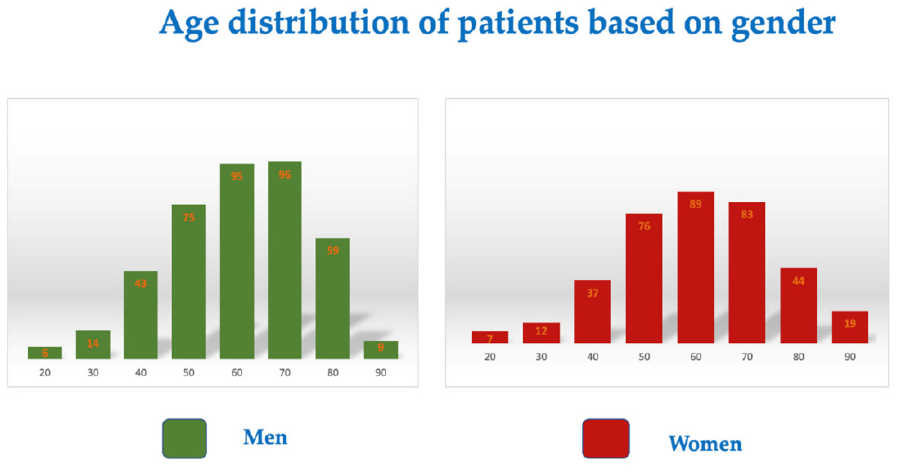
Figure 1. Age distribution based on gender.